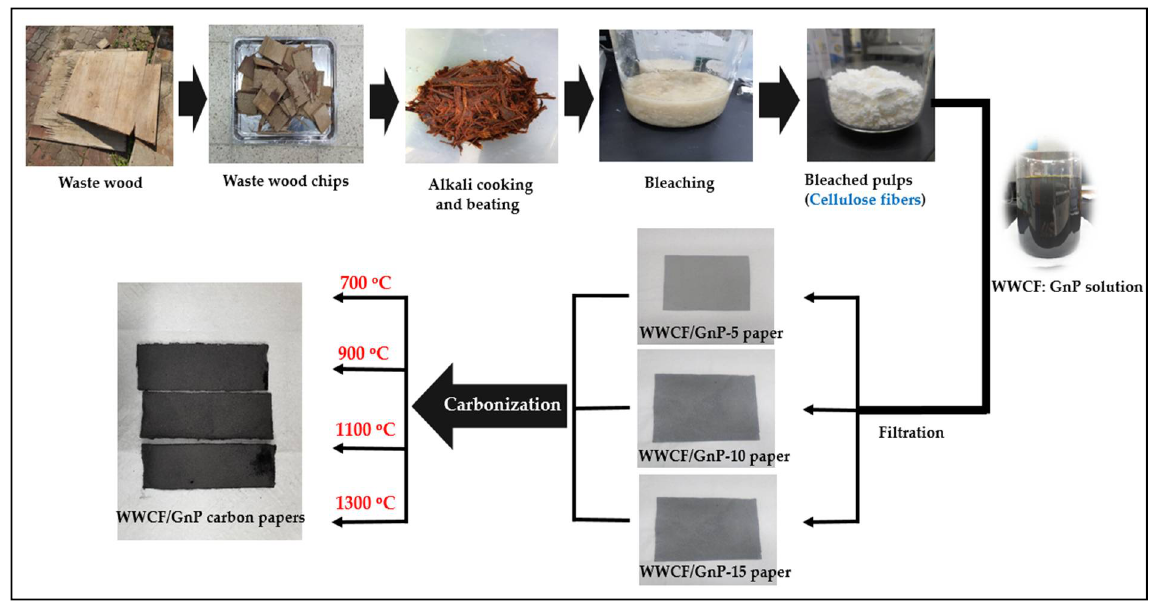
Figure 1. Schematic diagram to prepare waste wood cellulose fiber/graphene nanoplatelet (WWCF/GnP) carbon papers.